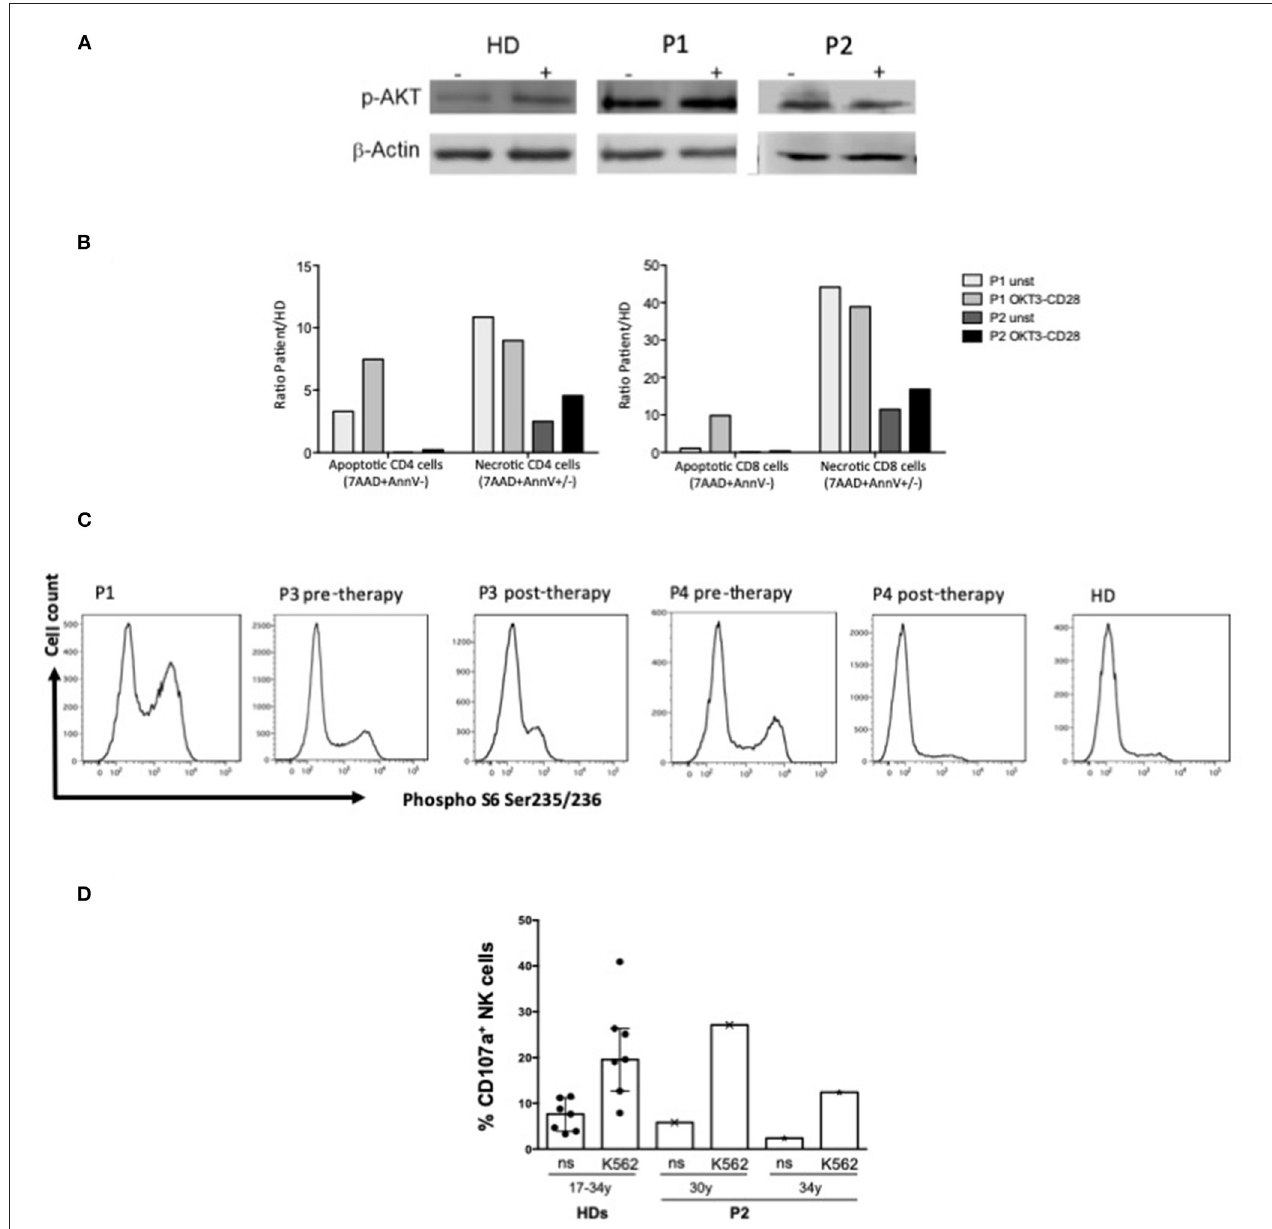
FIGURE 3 | Functional analysis. (A) Western blot analysis of p-Akt and β -actin protein expression in T blast from P1 (APDS1), P2 (APDS2) and HD with or w/o OKT3-CD28 stimulation (10min); (B) Percentage of apoptotic (7AAD-AnnexinV + ) or necrotic (7AAD + AnnexinV ± ) CD4 and CD8 gated cells from APDS1 (P1) and APDS2 (P2) patients with or w/o 48h of OKT3-CD28 stimulation. Results were showed as fold increase calculated as ratio between patients and HD. (C) Ex vivo phospho-S6 Ser235-236 intracellular staining performed on whole blood in CD3 + gated lymphocytes from P1 (APDS1) and P3 and P4 (APDS2) pre and post therapy with PI3K inhibitor and a healthy donor (HD). (D) Bar plots represent pattern of CD107a expression measured by flow cytometry on gated NK cells of an APDS2 patient at two time points (30 and 34 years of age) and of HDs ( n = 7, age ranging from 17 to 34 years) following 6h culture of PBMCs (effectors, E) with and without (not stimulated, ns) K562 cell targets (T) at an E:T ratio of 10:1. The median ± IQR is reported for HDs.